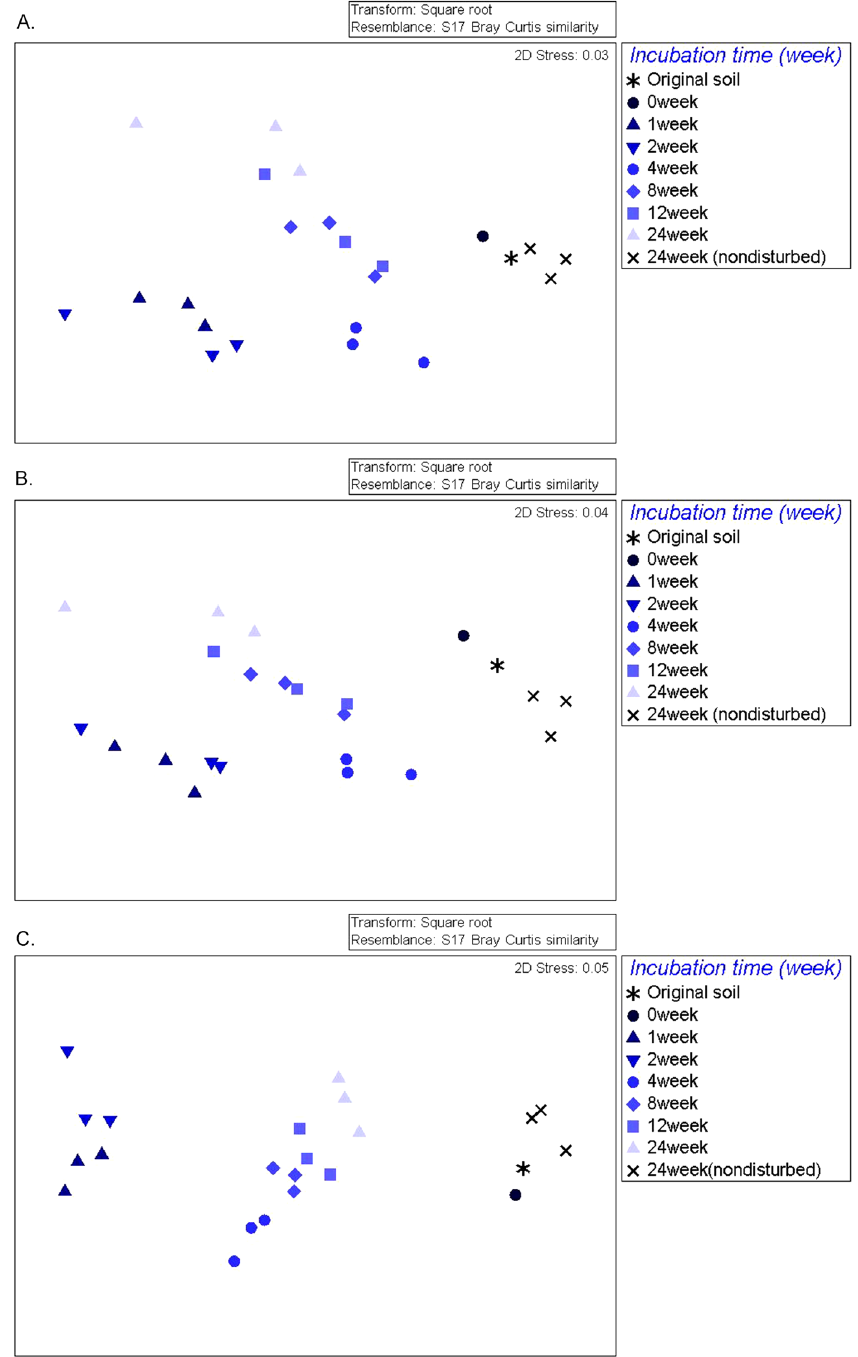
Figure 2. NMDS plot generated using weighted pairwise Unifrac distances between samples. ( A ) NMDS plot of shotgun metagenomic sequences based on M5NR taxonomic profile at family level, ( B ) NMDS plot of shotgun metagenomic sequences based on SEED functional profile at subsystem level 3, ( C ) NMDS plot of bacterial